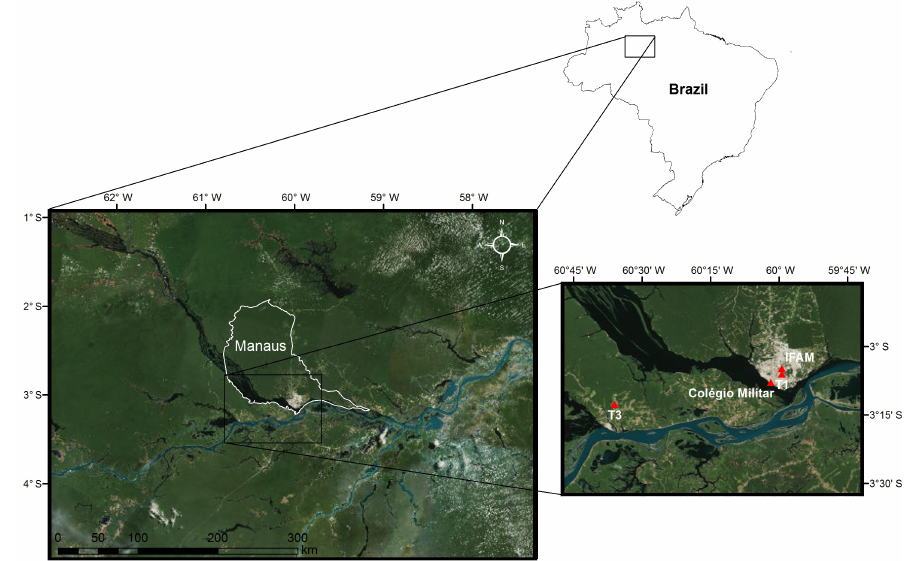
Figure 1. Geographic location of the study area, meteorology stations (Colégio Militar, IFAM and T3) and air quality station (T1). The white contour line shows the delimitation of the city of Manaus.